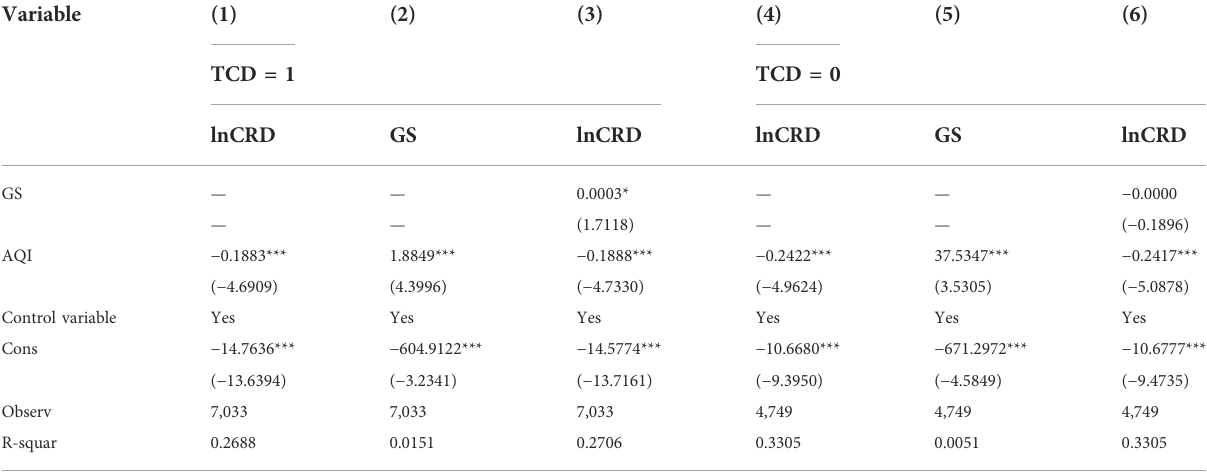
TABLE 7 Heterogeneity analysis of technical complexity based on government Concern.